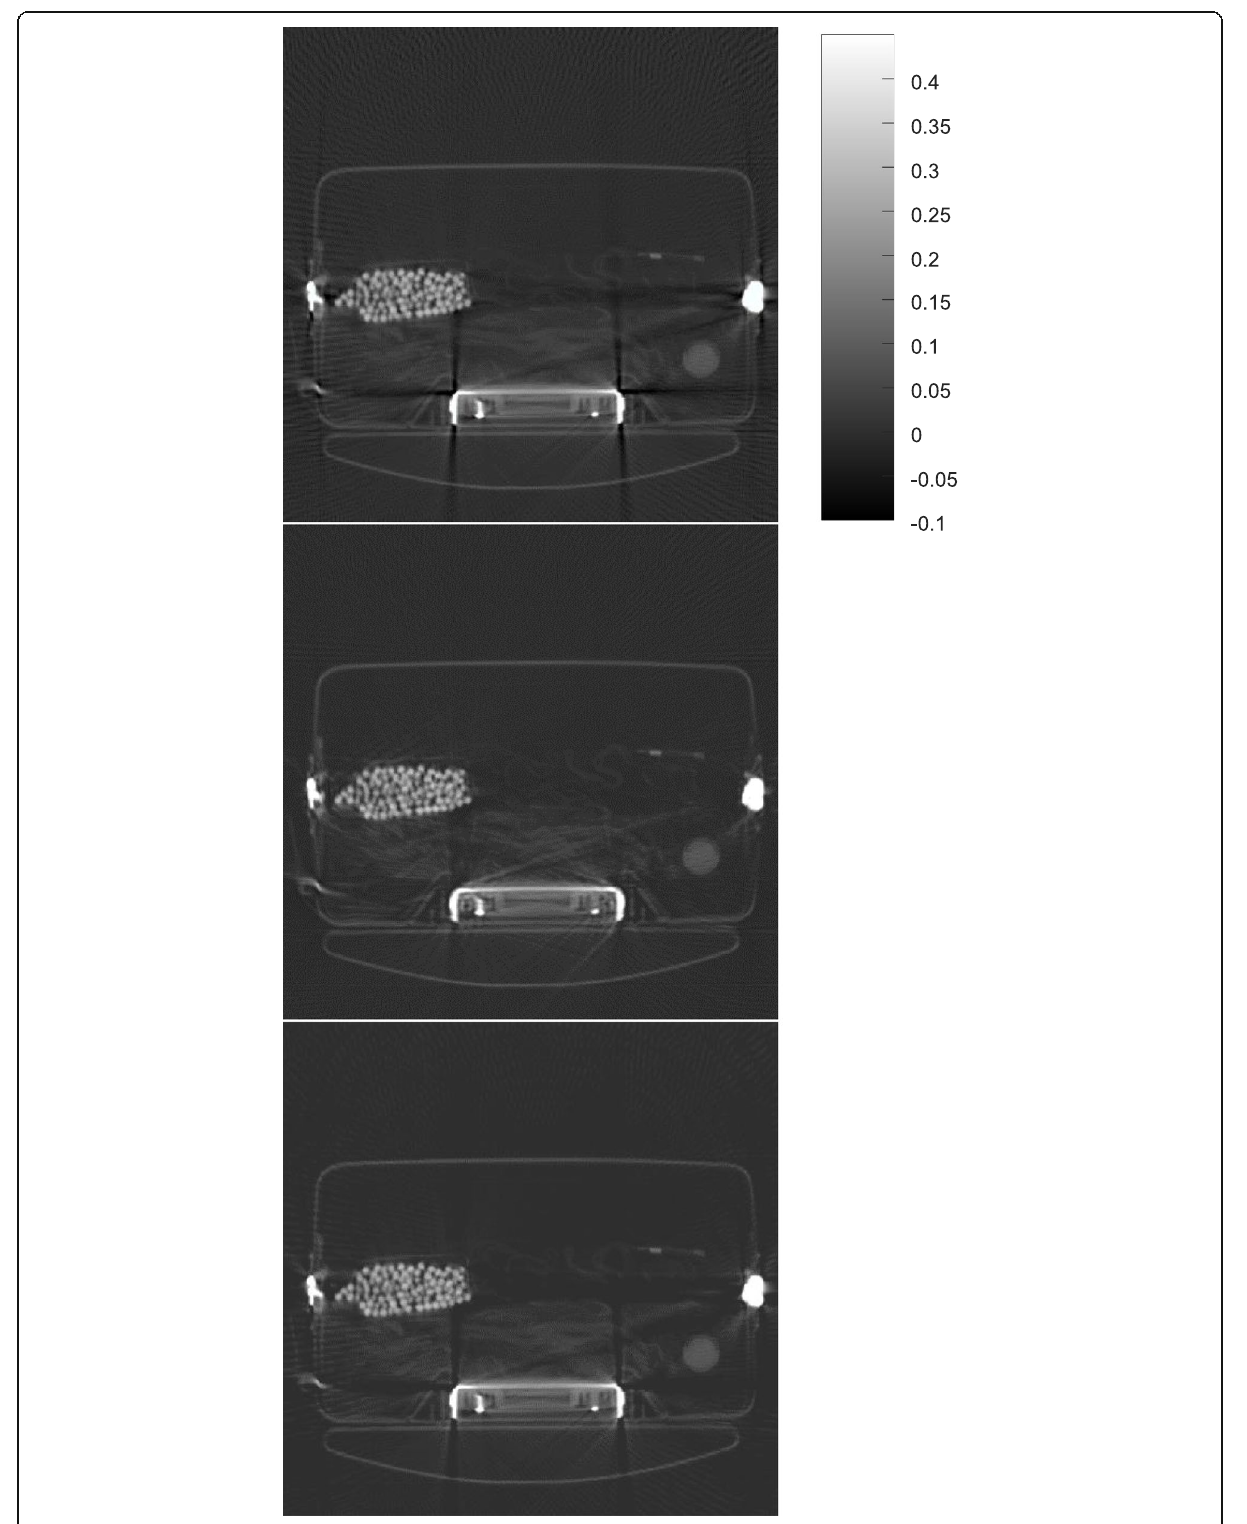
Fig. 2 CT image reconstruction of airport bag #2. Top: the raw FBP reconstruction; Middle: the reconstruction using the proposed algorithm; Bottom: the raw FBP reconstruction with all negative pixel values replaced by